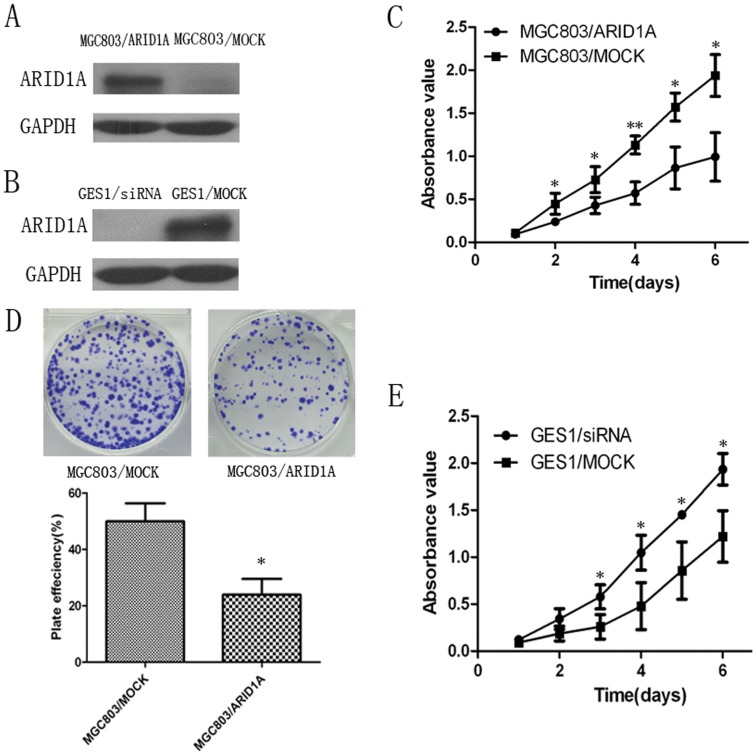
The growth suppressor role of ARID1A in cell proliferation and colony formation assays of MGC803 and GES1 cell lines.(A) Western blotting analysis of restoring ARID1A expression in MGC803 cells. (B) Western blotting analysis of silenced ARID1A expression in GES1 cells. (C) Cell proliferation assay showing the suppressive effect of restoring ARID1A expression on the in vitro proliferation of MGC803 cell line. (D) ARID1A inhibited colony formation of MGC803 cells. Images are shown on the left and on the right, quantitative analyses of plaque numbers are shown as mean ± SD. (E) Cell proliferation assay showing significantly enhanced proliferation rate of ARID1A-silenced GES1 cells compared with mock siRNA treatment GES1 cells. *, P<0.05 versus the mock-control; **, P<0.01 versus the mock-control.